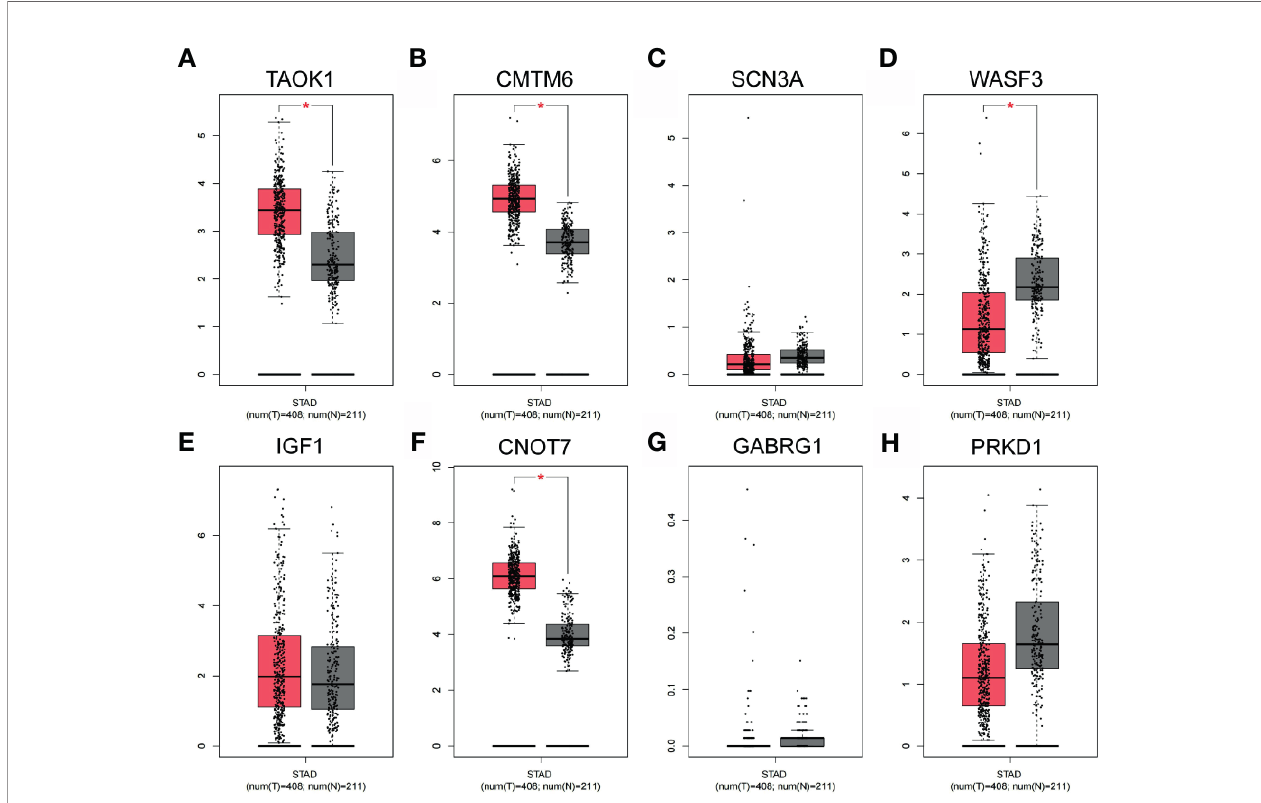
FIGURE 8 | Network hub gene expression analysis. (A) TAOK1. (B) CMTM6. (C) SCN3A. (D) WASF3. (E) IGF1. (F) CNOT7. (G) GABRG1. (H)